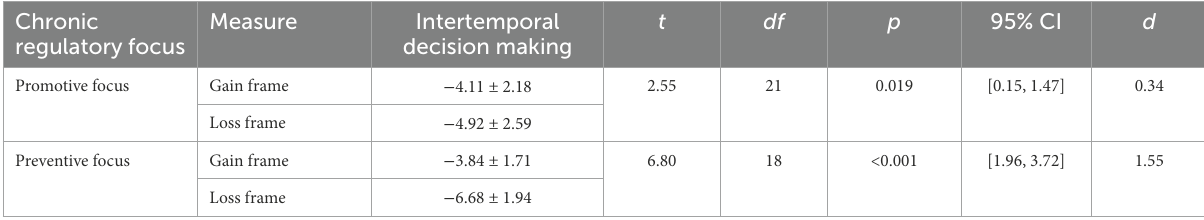
TABLE 3 An paired sample t -test for intertemporal decision making between promotive focus and preventive focus in the condition of upward social comparison. Chronic Measure regulatory focus